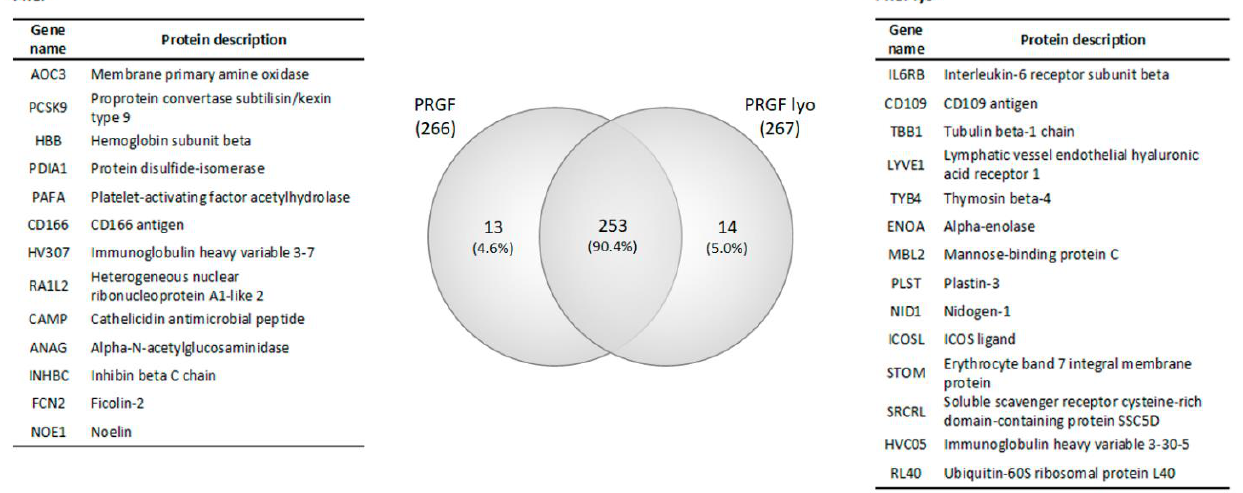
Figure 2. Venn diagram comparison of two blood – derived formulations and the list of proteins spe- cific for PRGF and PRGF